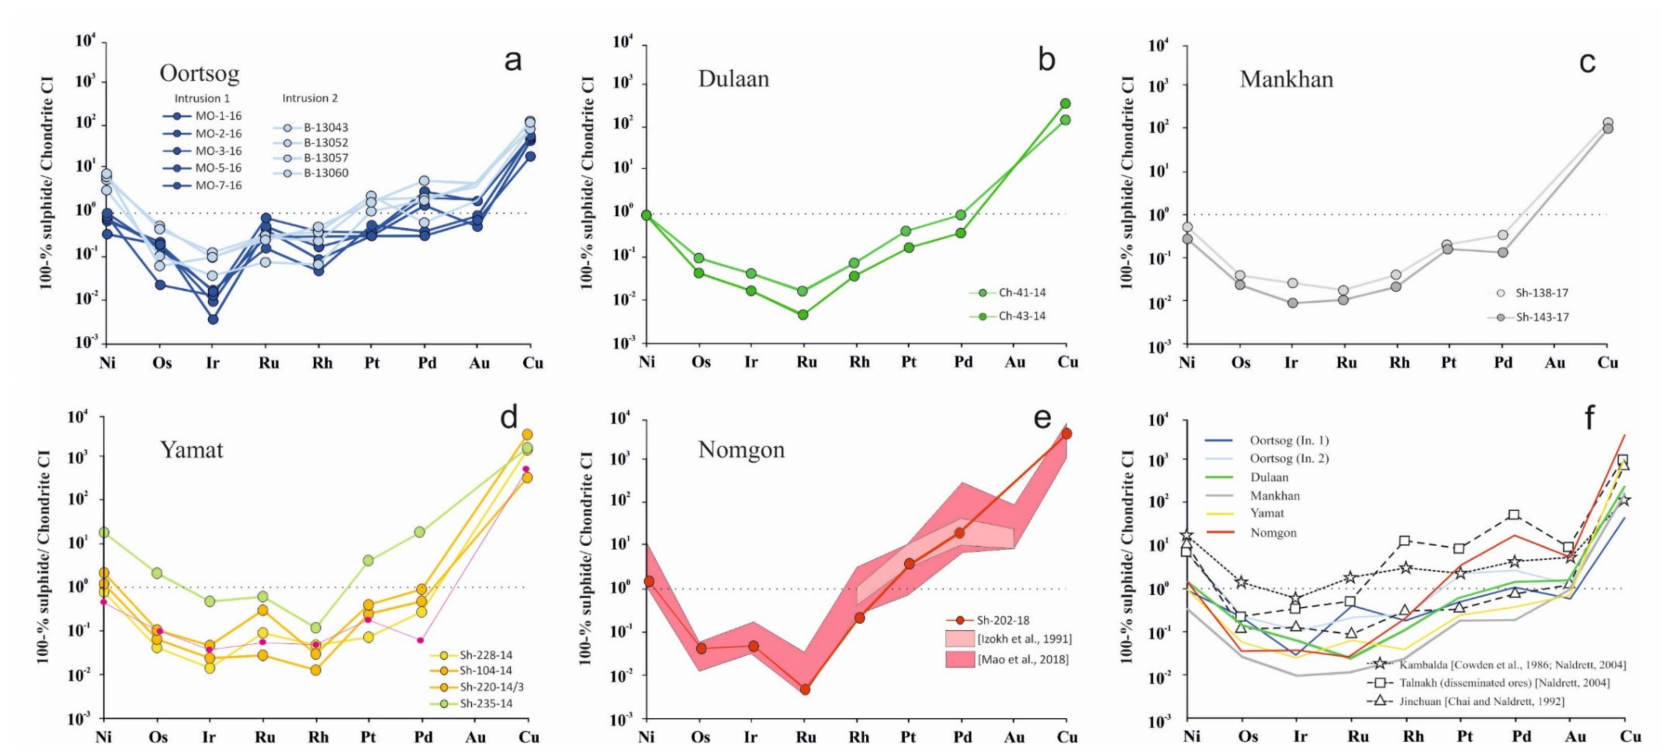
Figure 8. Chondrite normalized chalcophile-element distribution patterns for the mafic-ultramafic massifs of the Khangai upland in comparison with ores of other deposits related to ultramafic (Kambalda) and mafic (Talnakh, Jinchuan). All compositions are recalculated to 100% sulfide. References are given in Table 5. ( a ) Oortsog; ( b ) Dulaan; ( c ) Mankhan; ( d )Yamat; ( e ) Nomgon; ( f ) massifs of the Khangai upland and other